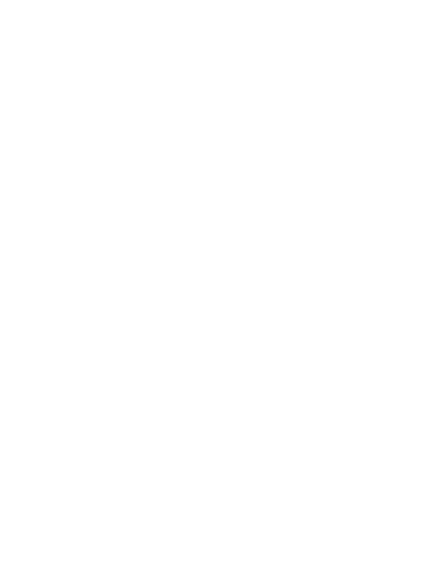
Figure 22. The shear fracture surface of the